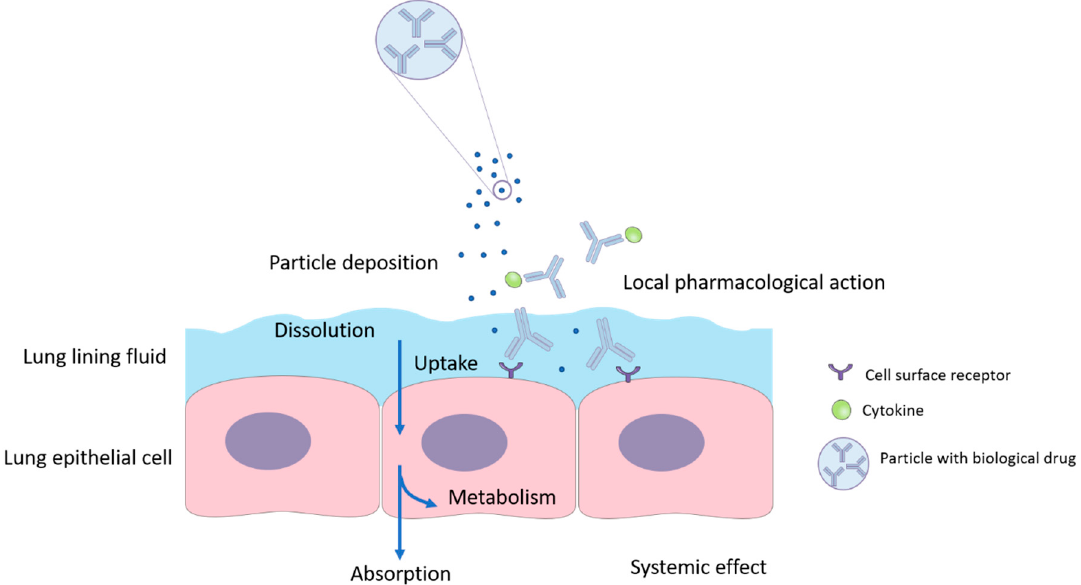
Figure 1. The fate of inhaled biological drugs in the airways upon lung deposition. Following dissolution in the lining fluid, the biological drugs either act on the surface of the epithelial cells, or being taken up by the cells where they are metabolised or absorbed into the systemic circulation.